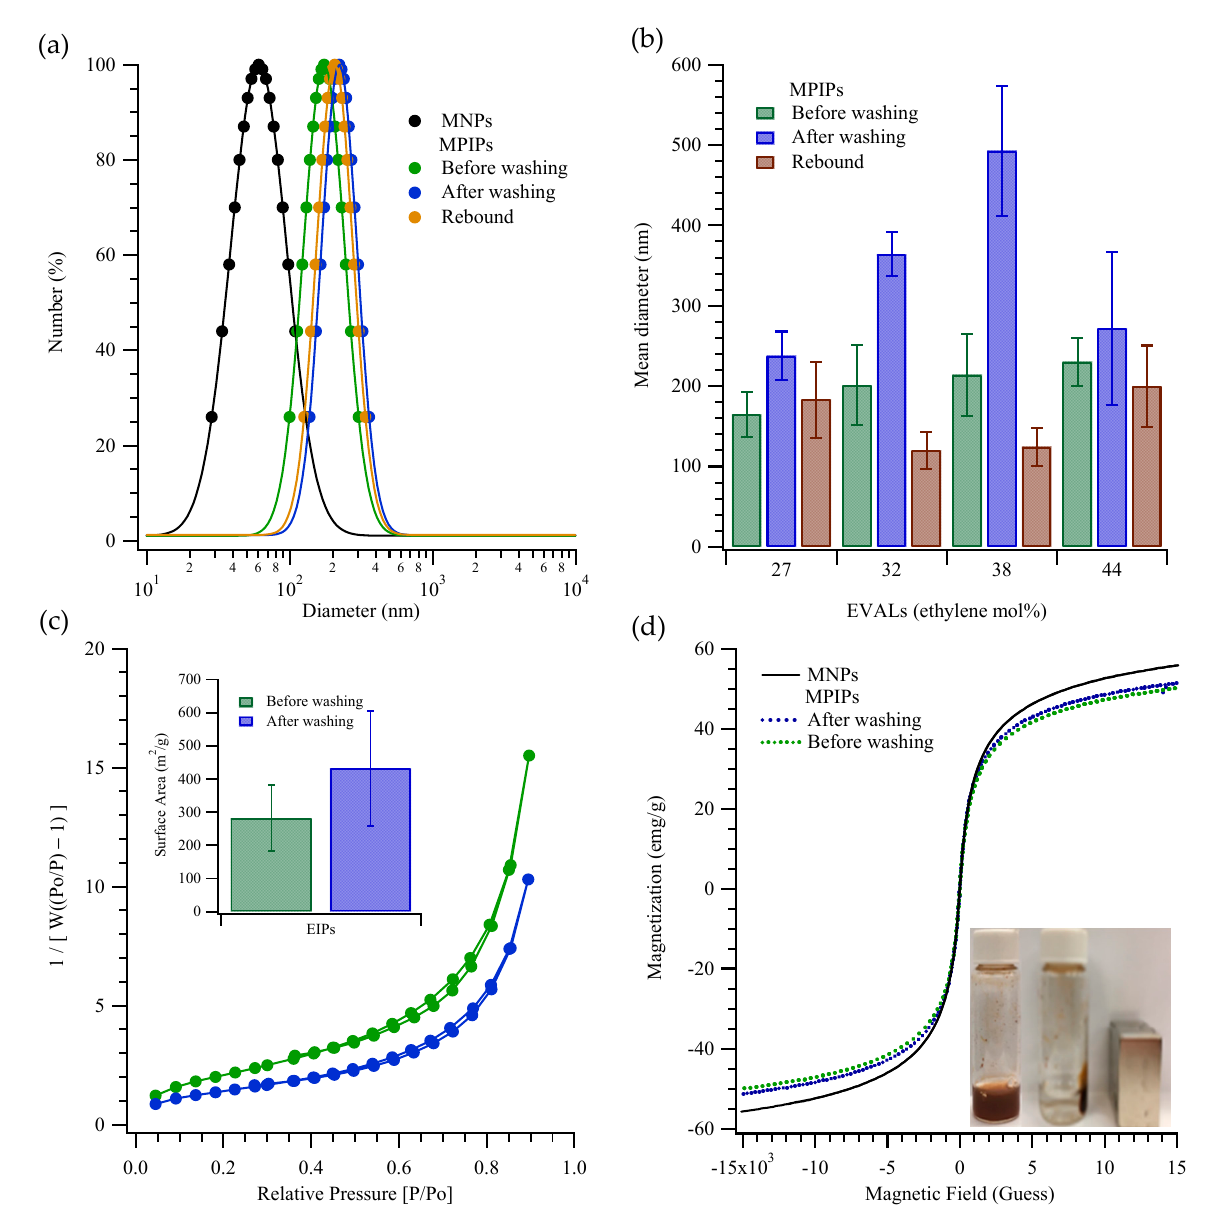
Figure 2. ( a ) Particles size distributions of MNPs ( • ); MPIPs before ( • ), after ( • ) template removal and rebound with template ( • ). ( b ) Mean diameters of MPIPs before, after template removal and rebound with template containing various ethylene mol% of EVAL. ( c ) Surface area of MPIPs before ( • ) and after ( • ) template removal measured by adsorption and desorption of nitrogen. ( d ) Magnetization of MNPs and MPIPs before and after template removal. Inset: MPIPs on the walls of a vial under magnetic field.